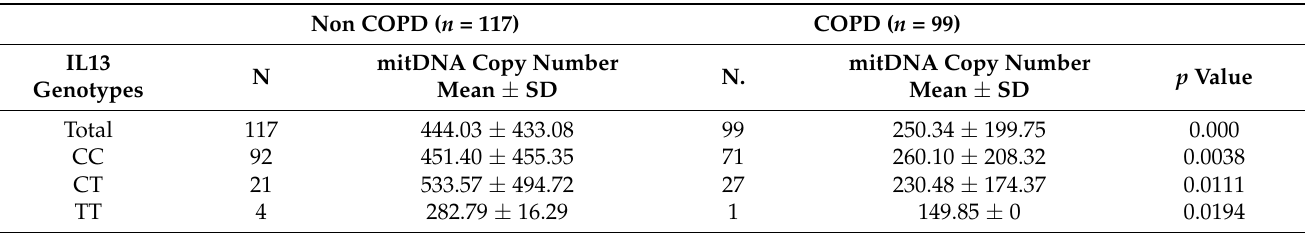
Table 2. Comparison of mitochondrial DNA copy number in individual IL 13 genotype (CC, CT, TT) in COPD and non-COPD